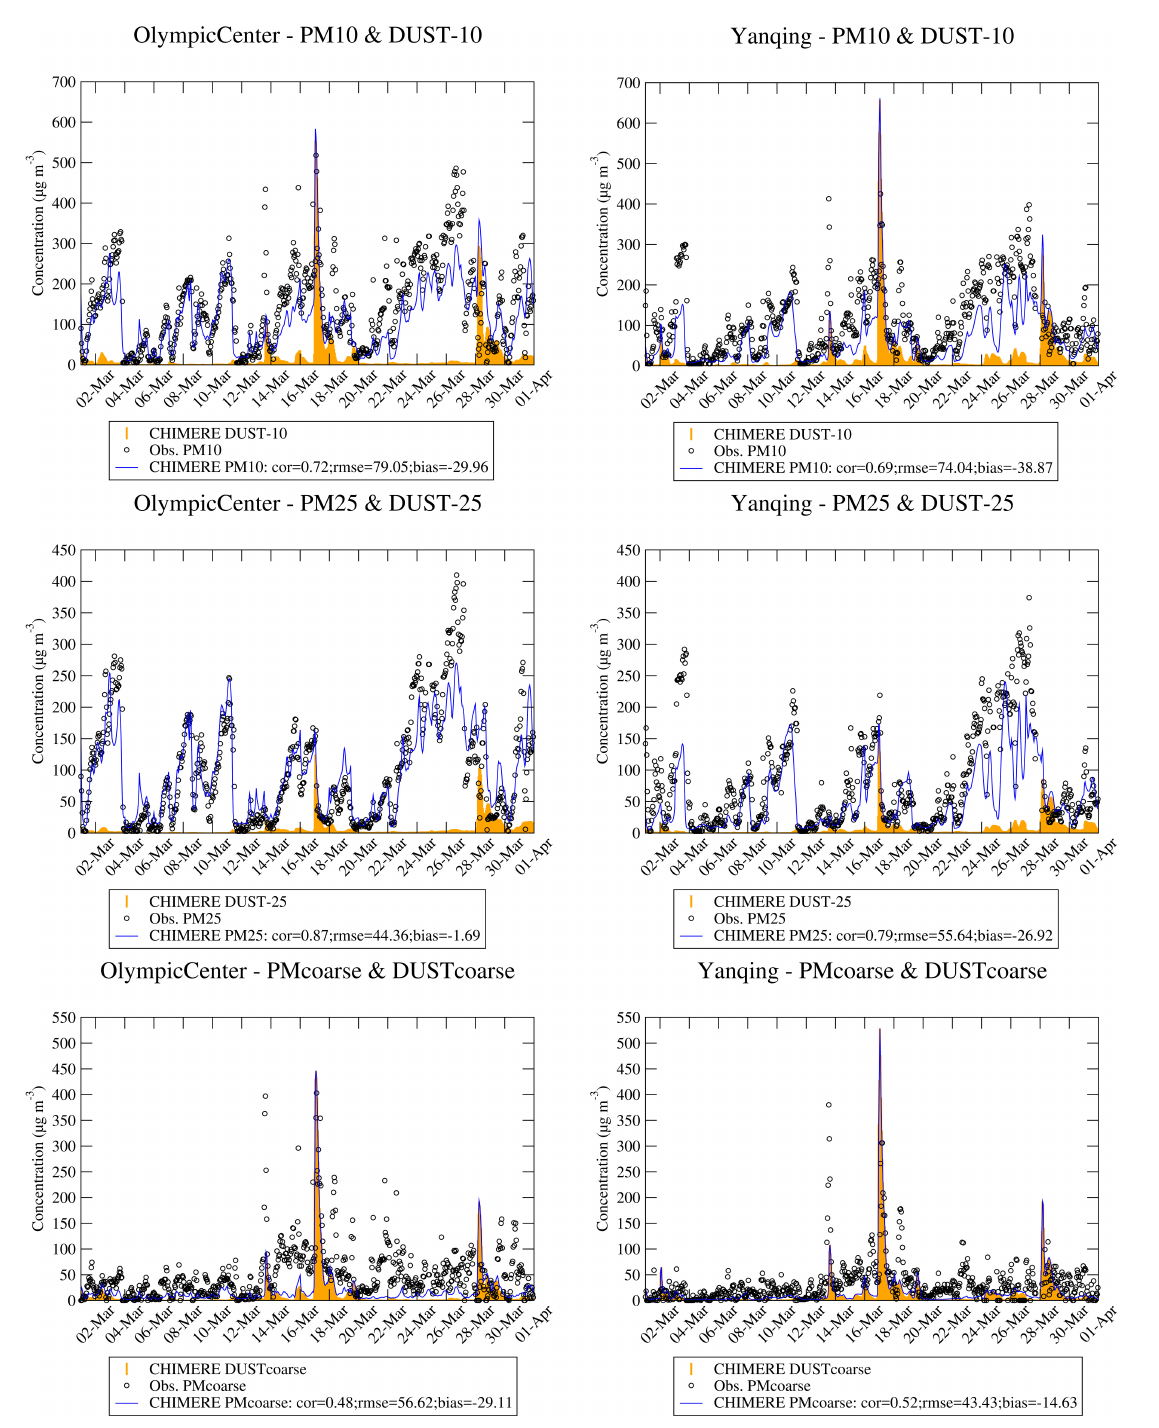
Figure 27. Hourly time series of PM concentrations and dust concentrations issued from CHIMERE for the PM 2.5 , PM 10 and PM coarse fractions versus observed values for two stations in Beijing: Yanqing (40.45 ◦ N–115.97 ◦ E) as a rural site located in the northeast of Beijing close to the Great Wall, and Olympic Center (39.98 ◦ N–116.40 ◦ E) as a urban site close to the center of Beijing. The orange shade area represents the dust concentrations simulated by CHIMERE for the corresponding PM